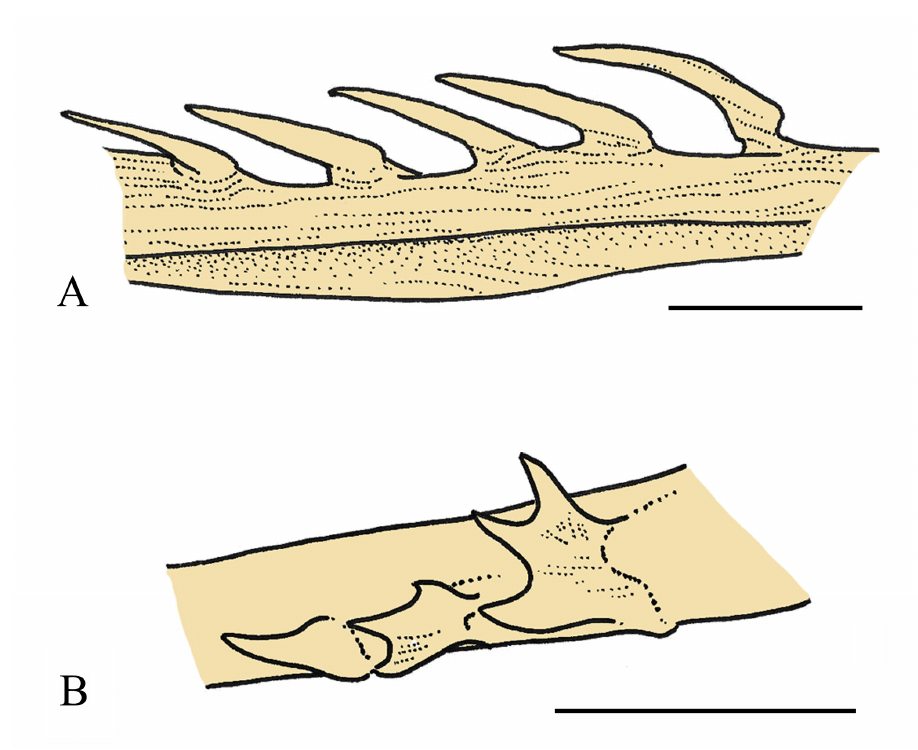
FIGURE 7 | Shape of gill rakers on the first ceratobranchial; lateral view of left selected portion; anterior to left: A. Steindachneridion scriptum , MZUEL 19302; B. Lophiosilurus alexandri , MZUEL 5542. Scale bars = 5